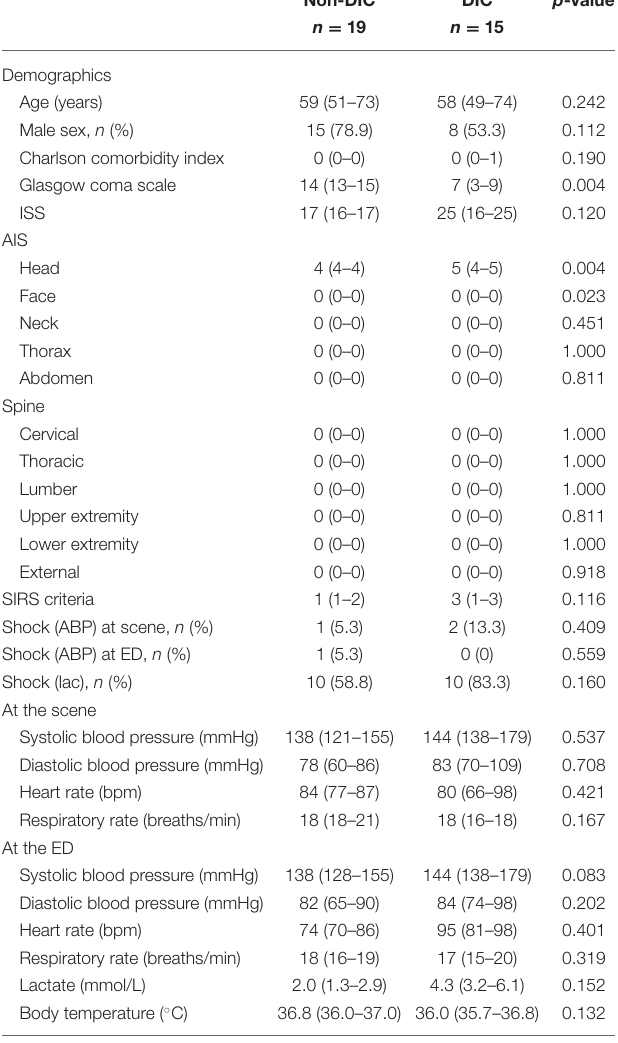
TABLE 4 | Demographics and parameters at the scene and admission to the emergency department in isolated traumatic brain injury patients with and without disseminated intravascular coagulation.